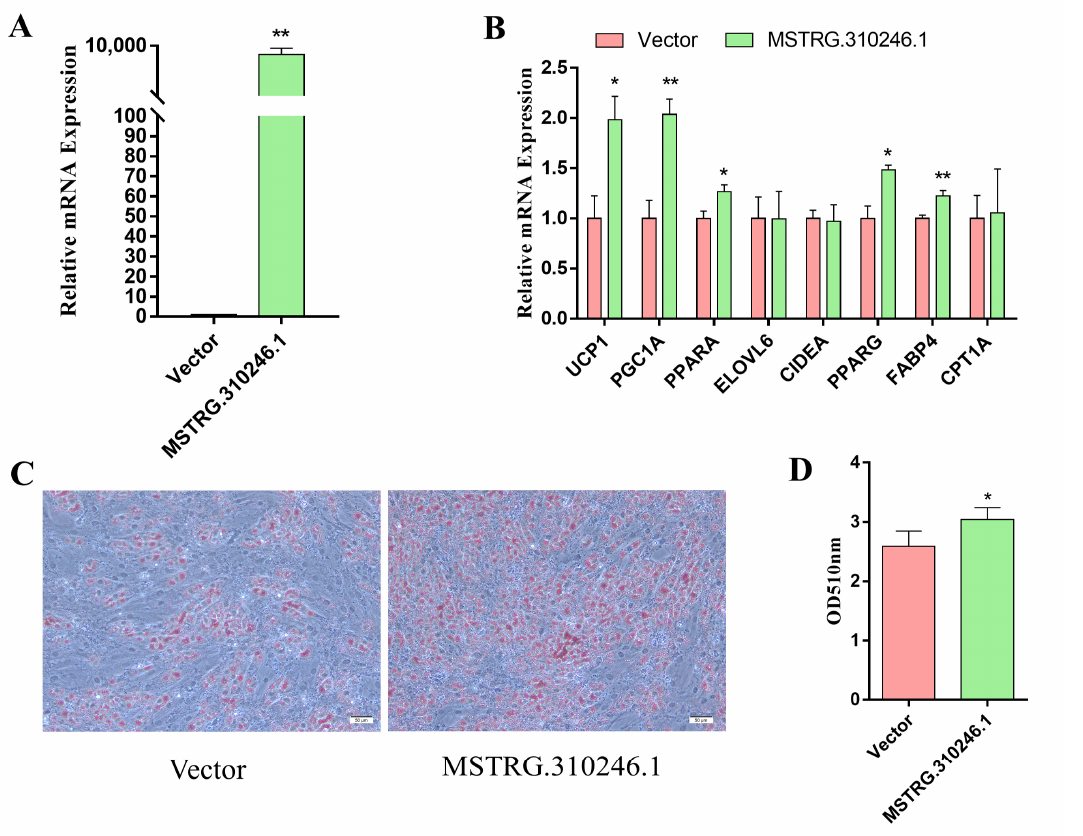
Figure 2. Overexpression of MSTRG.310246.1 induced the differentiation and thermogenesis of brown adipocytes. ( A ) Overexpression of MSTRG.310246.1 in goat brown adipocytes. ( B ) Gene expression in goat brown adipocytes transduced with MSTRG.310246. ( C , D ) Oil-red-O staining of brown adipocytes transduced with MSTRG.310246.1. Bar: 50 µ m. The absorbance at 510 nm was detected. Error bars represent SEM, n = 6, * p < 0.05, ** p <